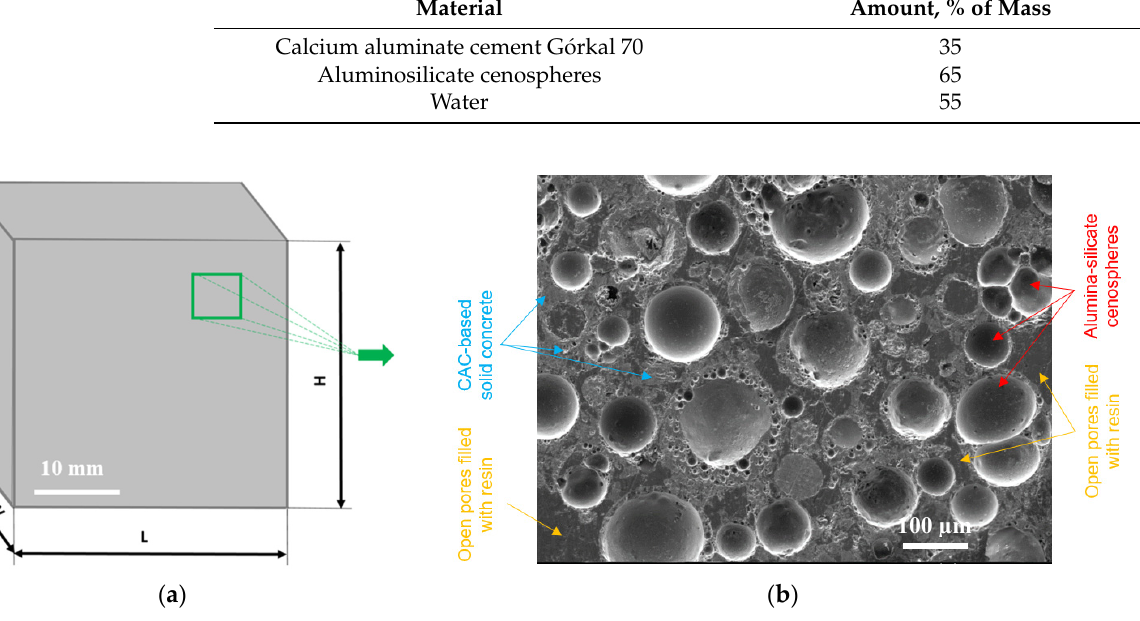
Figure 3. ALRC sample: ( a ) Cube-shaped L × W × H = 40 × 40 × 40 mm; ( b ) Microstructure SEM image.